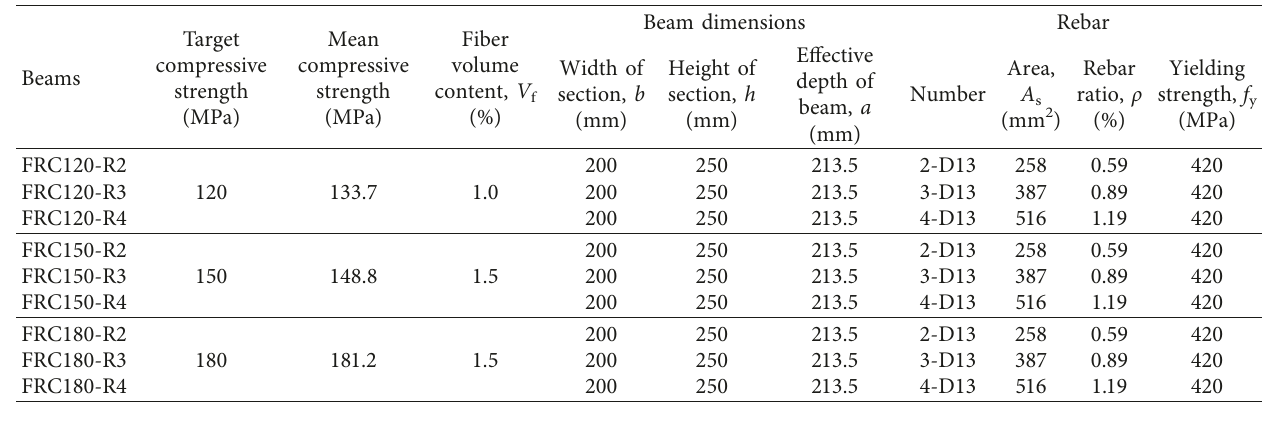
Figure 6: Dimensions of the beam. Table 3: Details of the beams.